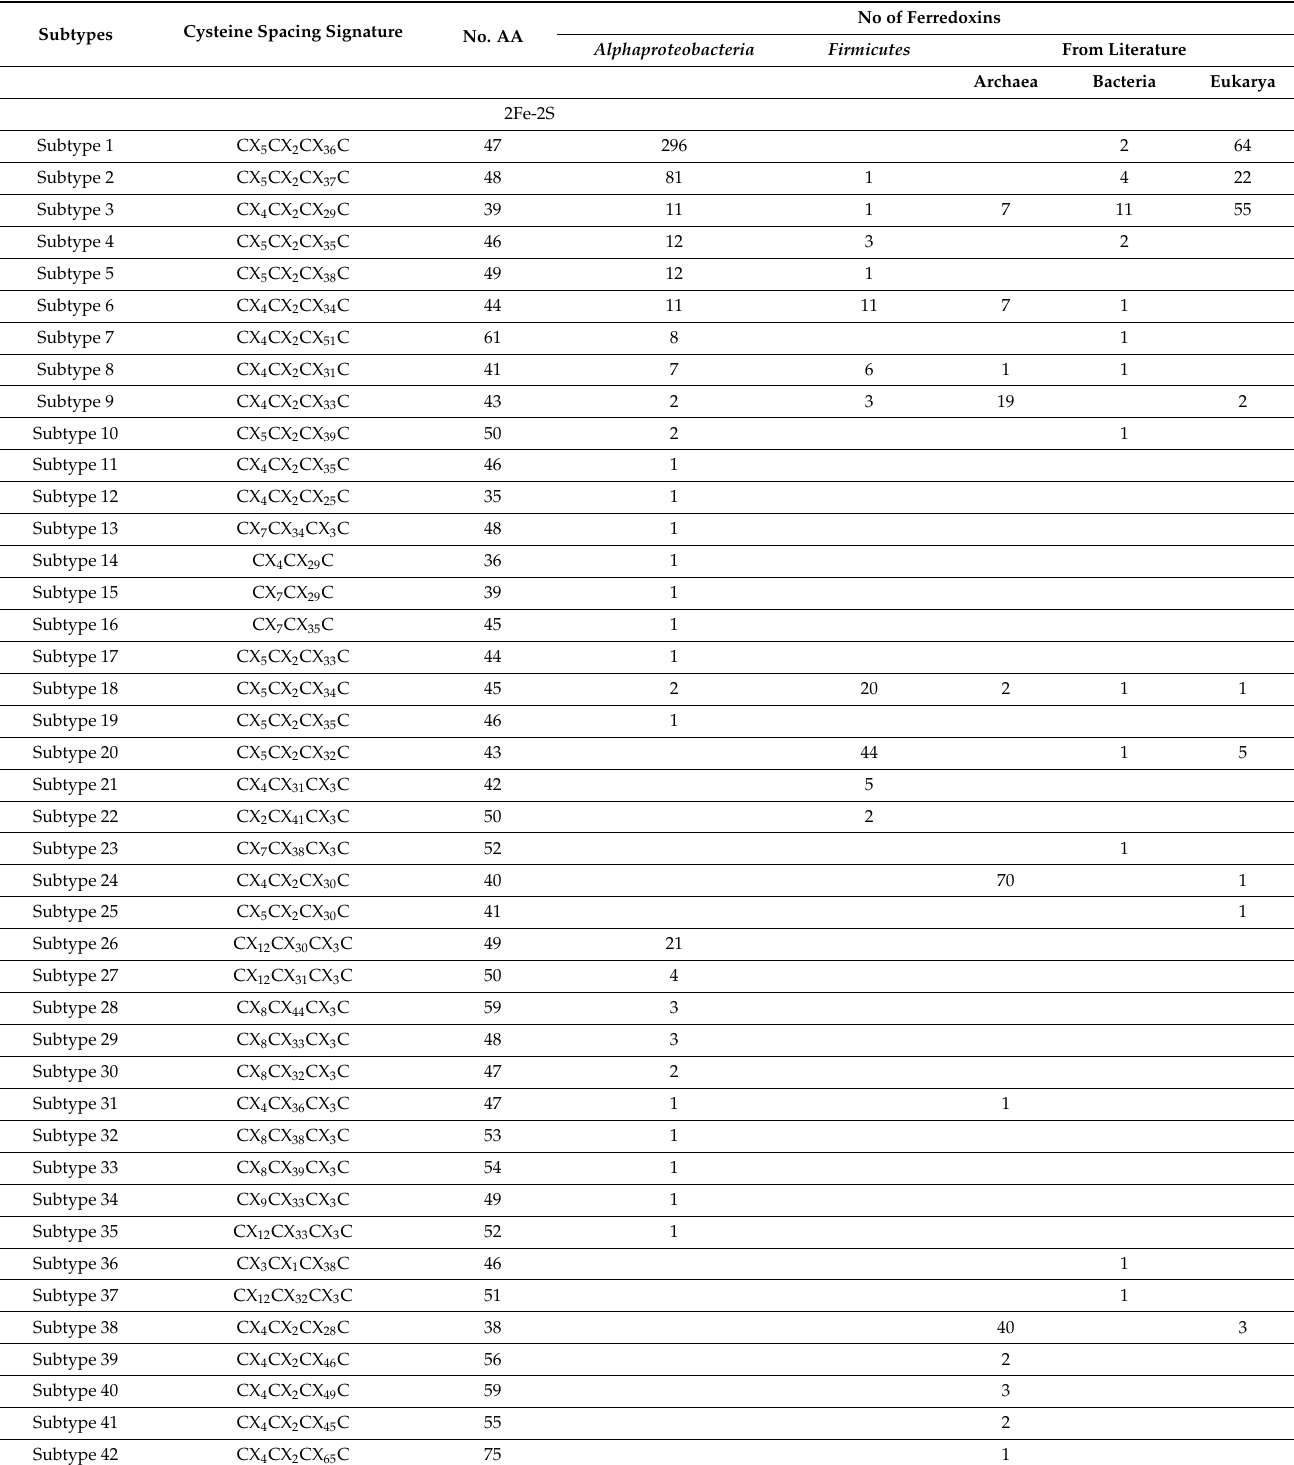
found between alphaproteobacterial species and Firmicutes species (Table 2), indicating 4Fe-4S ferredoxins are highly diverse between these two bacterial groups. Table 2. Subtype classification of ferredoxin across the domains of life. Ferredoxins collected from species belonging to different biological kingdoms that are reported in the literature and data mined at Protein Data Bank (PDB) also presented in the table as per their subtypes under the domains: Archaea, Bacteria, and Eukarya. Ferredoxin protein sequences as per their nomenclature are presented in Tables S2 and